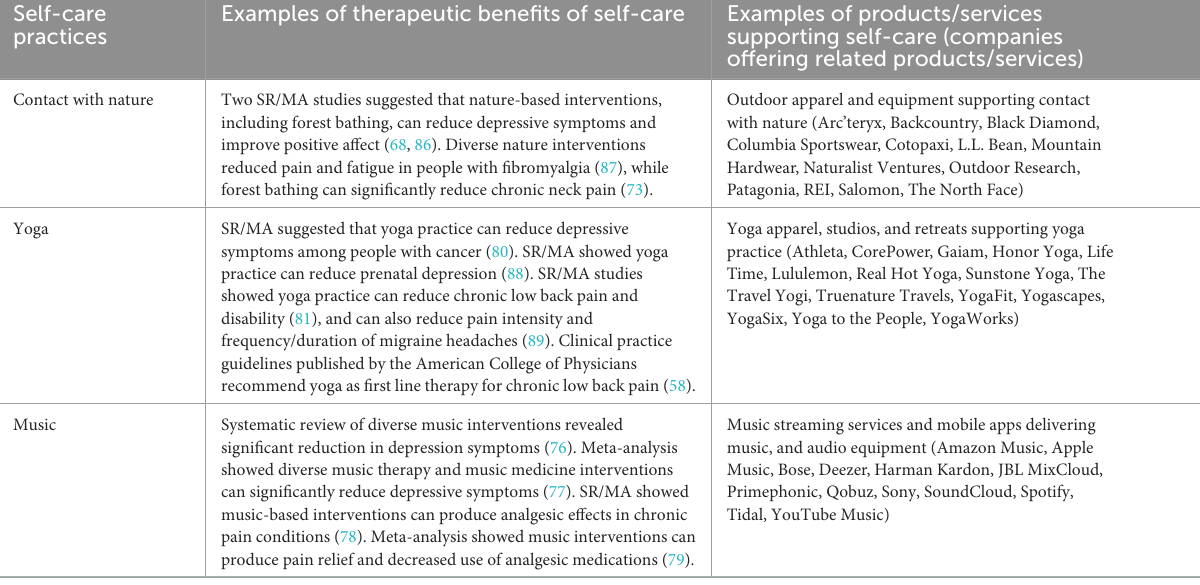
TABLE 1 Examples of self-care practices and related products and services that can benefit people living with chronic pain and depression. Self-care